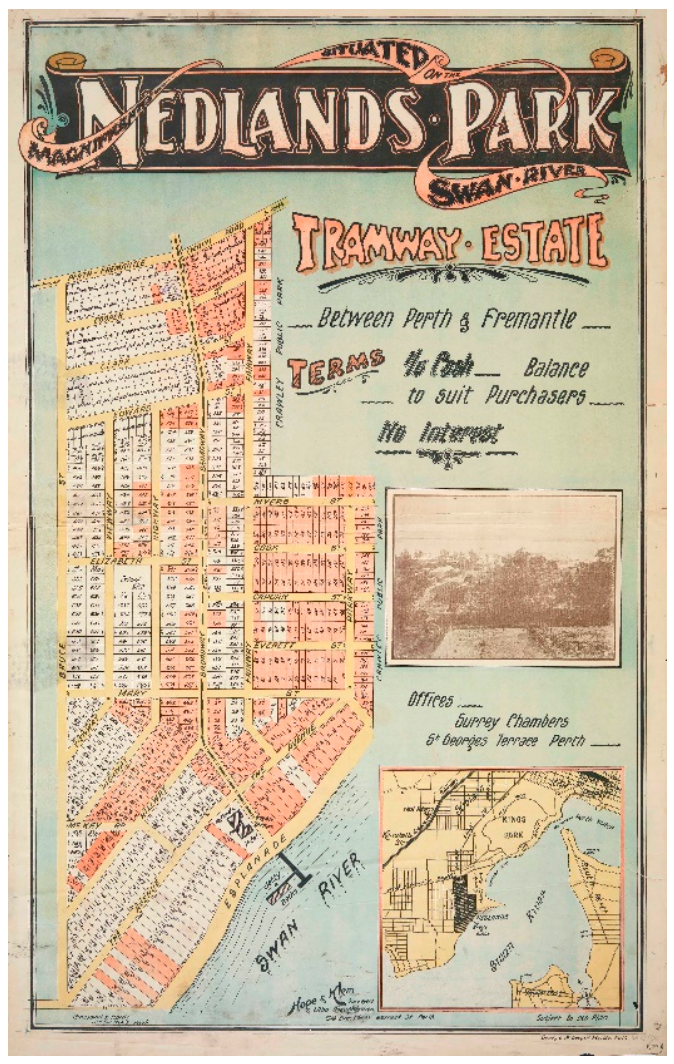
Figure 4. Nedlands Park Tramway Estate map. Source: Battye Library.